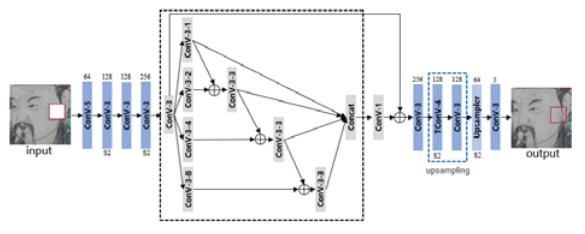
Figure 2 . Generative Model